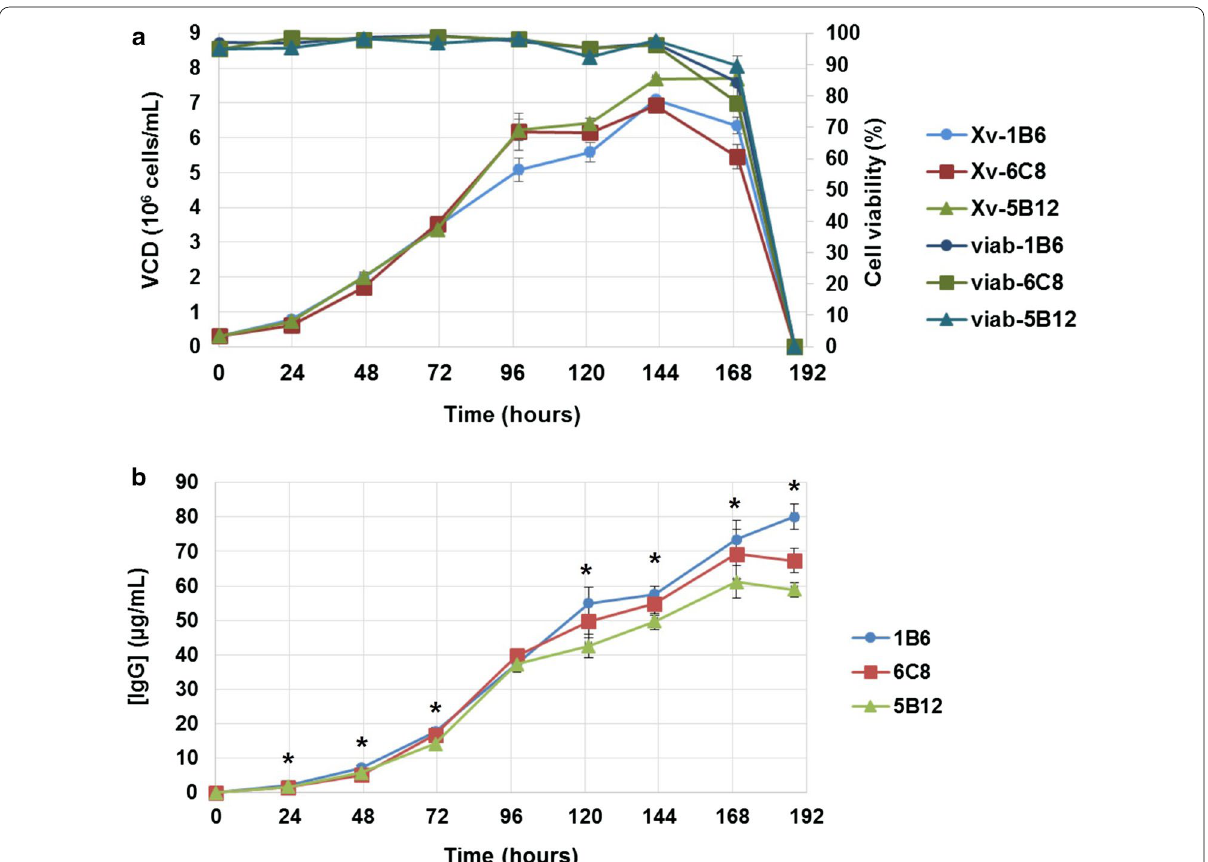
Fig. 8 Batch culture for selected trastuzumab‑expressing clones in chemically defined, protein‑free medium and shaking culture. a Growth profile. b Titer of clones. Shaking Erlenmeyer flasks with 60 mL of CP‑CHO‑CB5 medium were inoculated with 0.3 x 10 6 cells/mL. The experiment was performed in duplicates. These flasks were incubated at 37 °C in the presence of 5% CO 2 and shaking culture (120 rpm) (Infors HT, Switzerland). VCD: viable cell density. All the clones are originated from parental cell oligoclone 10D3. The data correspond to mean difference between means of almost two clones